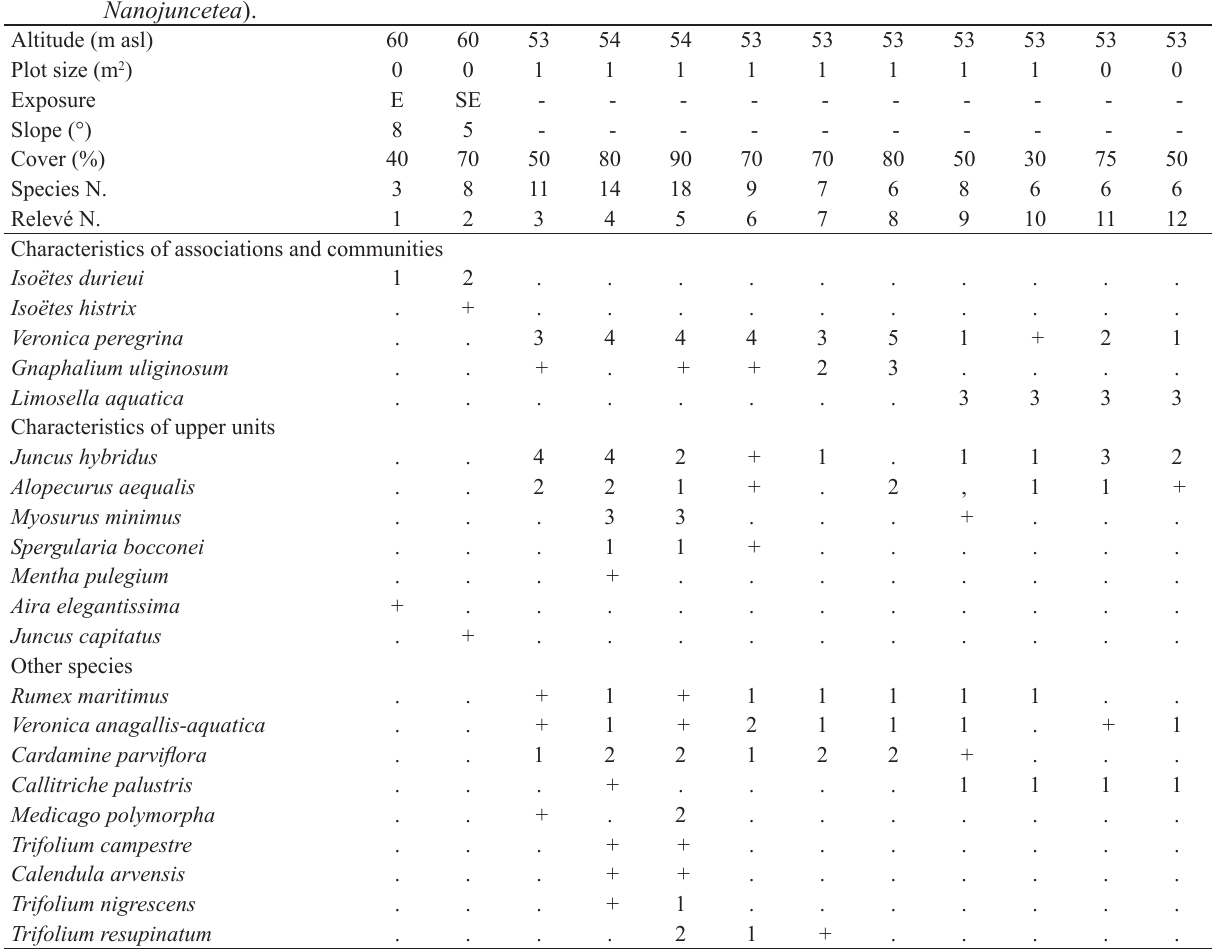
Table 3. Pioneer ephemeral vegetation of temporary ponds and muds. Isoëtetum duriei Br.-Bl. 1935 (rel. 1,2) ( Isoëtion durieui , Isoëtetalia durieui , Isoëto-Nanojuncetea ); Filaginello uliginosae-Veronicetum peregrinae Molero Brion. & Romo 1988 (rel. 3-8) ( Nanocyperion flavescentis , Nanocyperetalia flavescentis , Isoëto-Nanojuncetea ); Limosella aquatica comm. (rel. 9-12) ( Eleocharition soloniensis , Nanocyperetalia flavescentis , Isoëto- Nanojuncetea ).